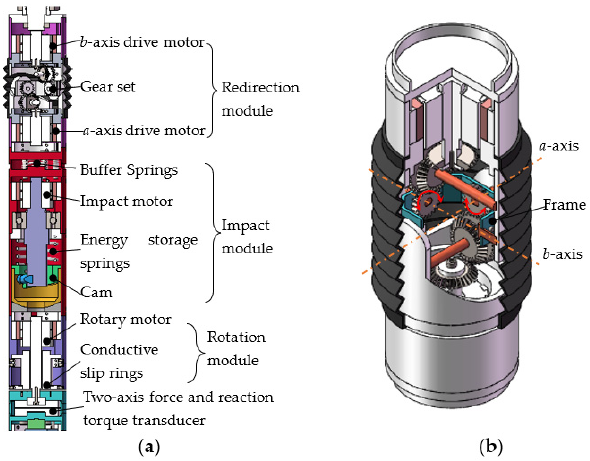
Figure 5. Design of the drilling part ( a ) Modules configuration ( b ) Operating mechanism of the redirection module.